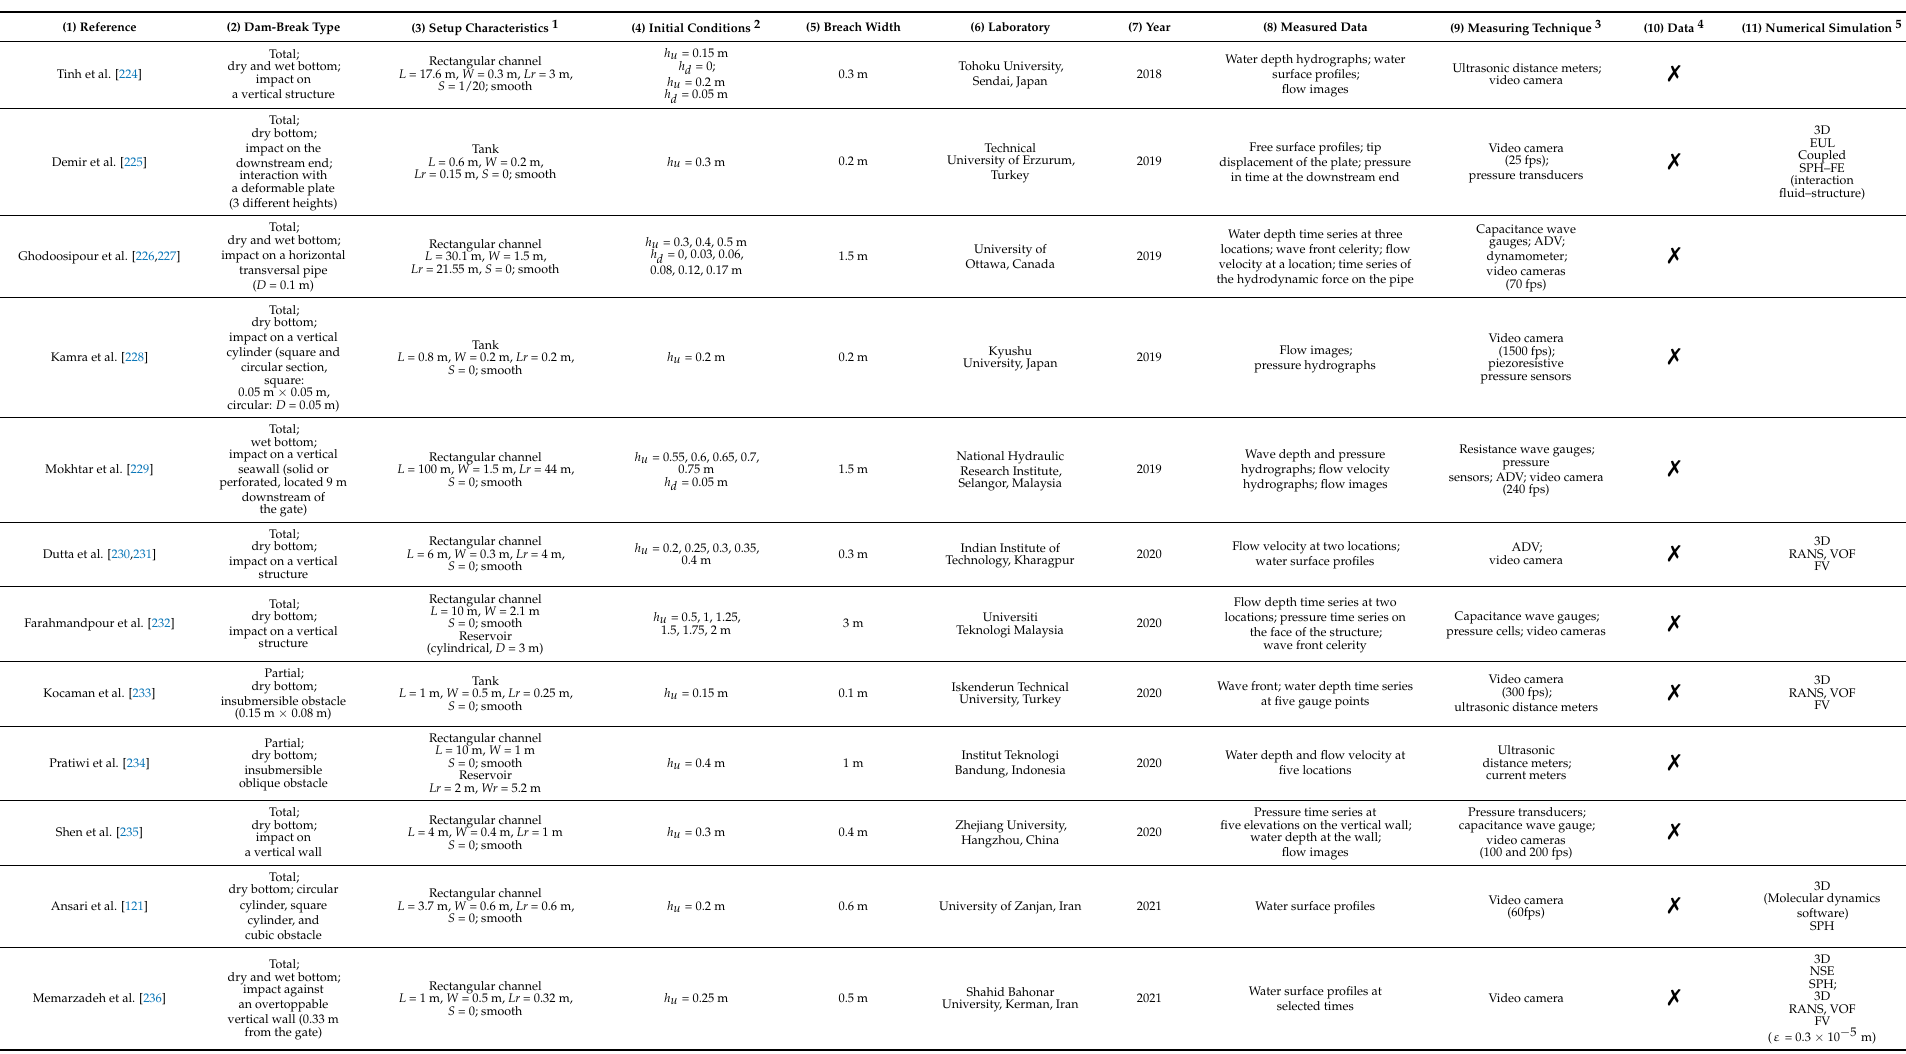
Table 1. Basic experimental investigations of fundamental dam-break wave physical characteristics.